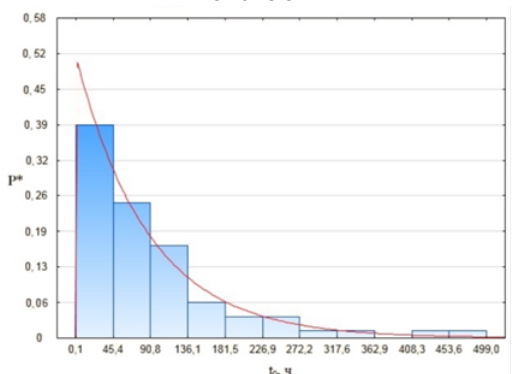
Figure 3. Histograms and distribution frequency functions of a time per fault of a control system of rope shovels